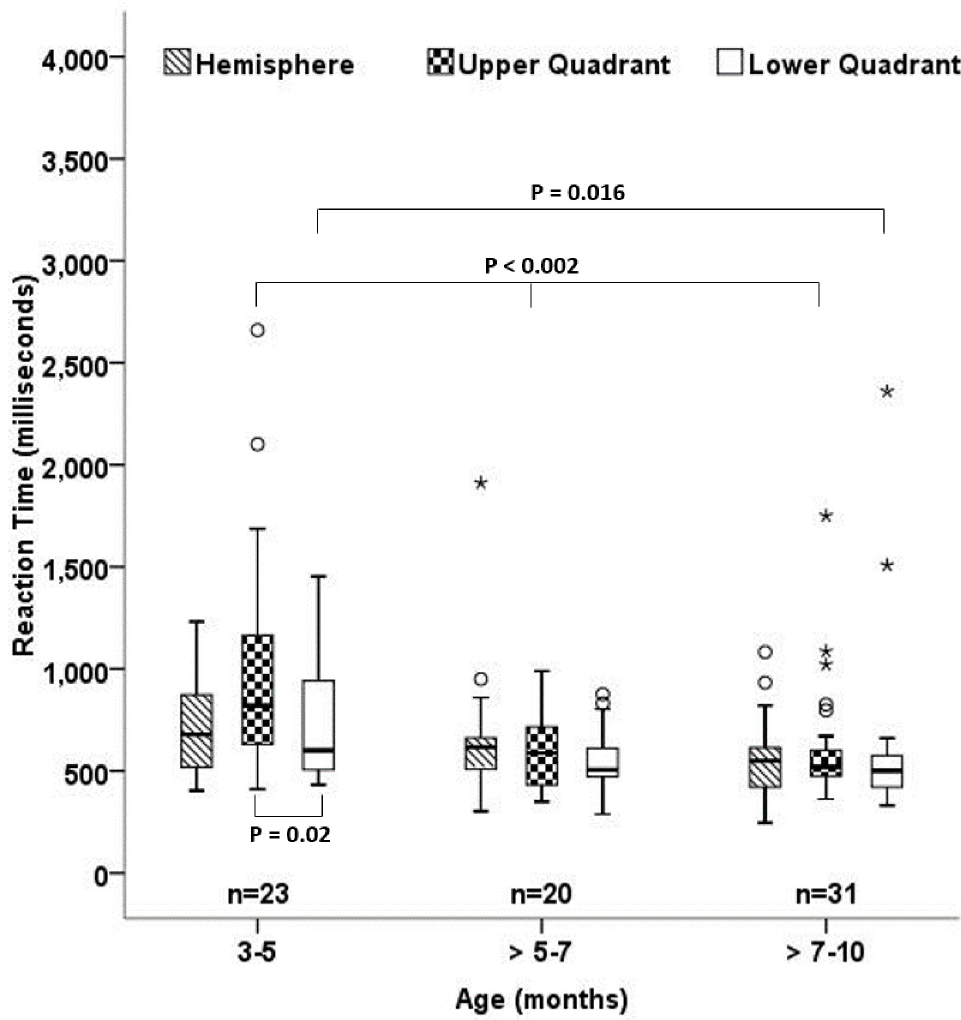
Fig 2. Box plot shows the reaction time measured in milliseconds for the 3 different age groups (x-axis) to the hemifields, upper quadrants and lower quadrants. The box denotes the interquartile range. Outliers (o) and extreme ( � ) values are also plotted.